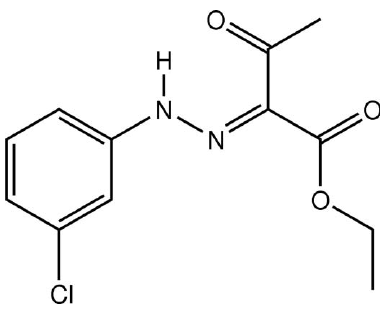
Experimental Crystal data